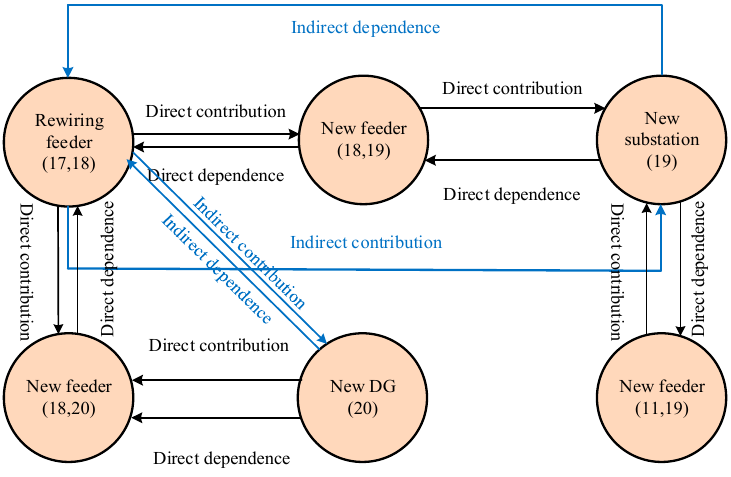
indirect contribution to proj.5, while the latter has an indirect dependence on the former.